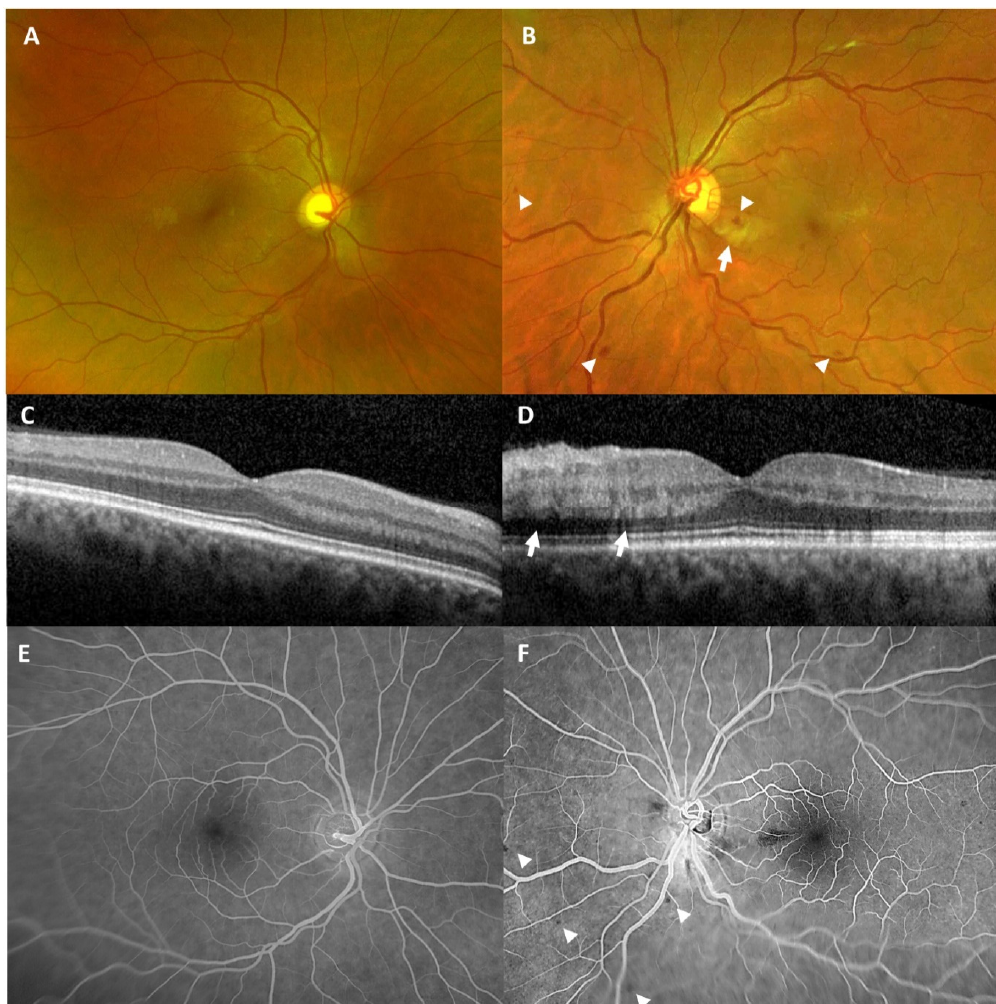
Figure 3. Wide-angle fundus photography ( A , B ) at initial presentation showed a normal right eye ( A ) and intraretinal hemorrhages (white arrow heads) as well as a parapapillary cotton-wool spot, seen as a fluffy yellow spot (white arrow), in the left eye ( B ). Optical coherence tomography of the macula ( C , D ) revealed a normal right eye ( C ) and a slight swelling of the inner retina (white arrows) in the left eye ( D ). Fluorescein angiography ( E , F ) two weeks later showed no abnormalities in right eye ( E ) and blocked fluorescence, due to persistent intraretinal hemorrhages (white arrow heads), but no ischemic lesions in the left eye ( F ).